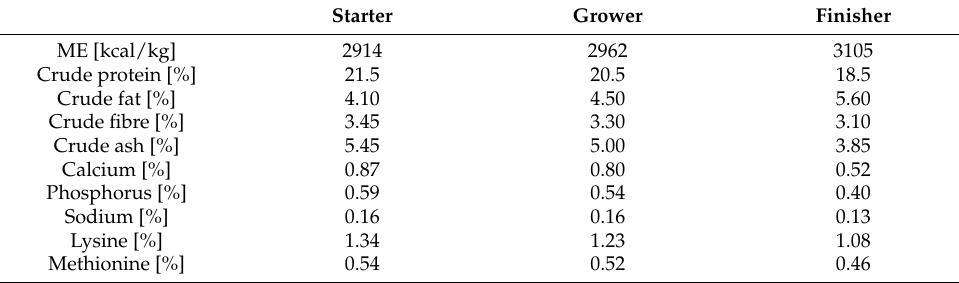
Table 2. Calculated compositions of the